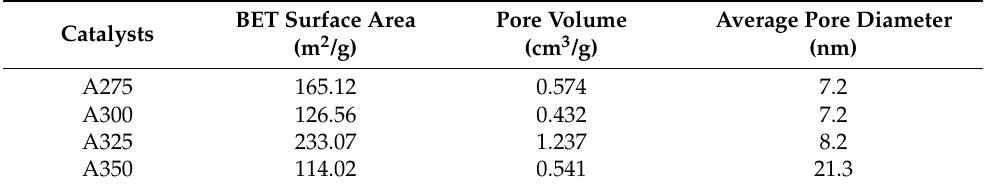
Table 1. Textural properties (surface area, pore volume, and pore distribution) of the